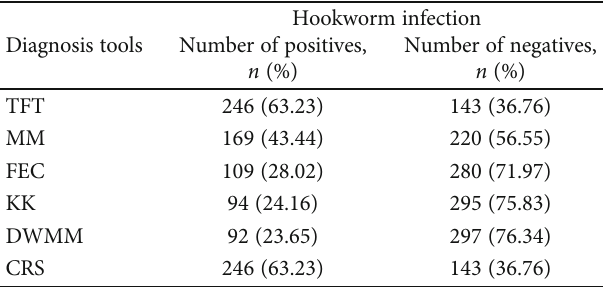
Table 1: Hookworm positivity rate by diagnosis techniques among the study